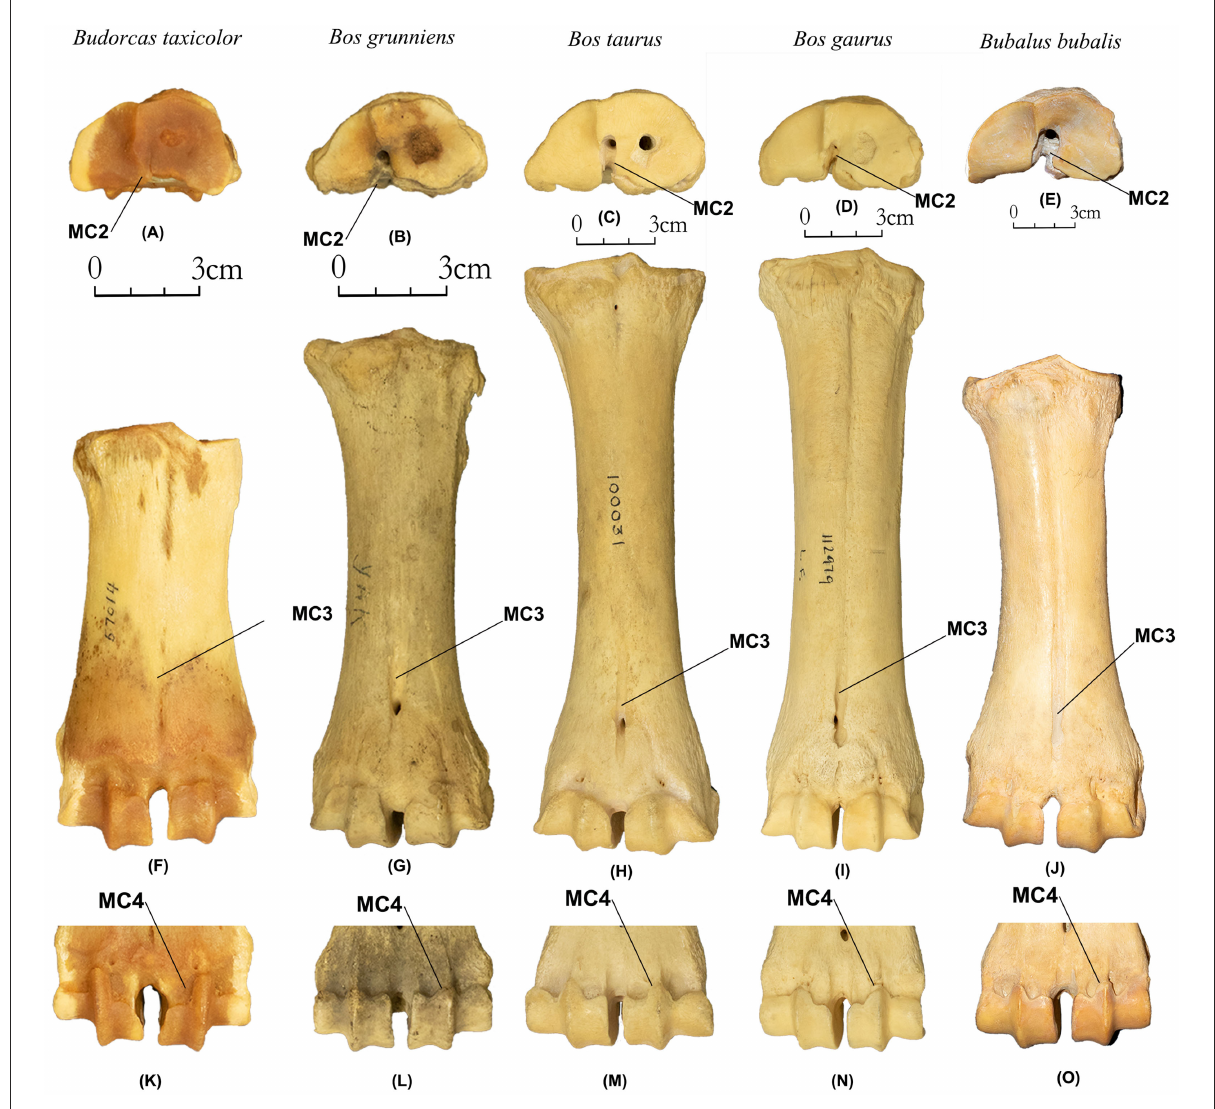
FIGURE6 Metacarpal of takins and Bovini. Proximal view: (A) Budorcas taxicolor (AMNH − 57014), (B) Bos grunniens (AMNH–M − 22909). (C) Bos taurus (AMNH–M − 77932). (D) Bos gaurus (AMNH–M − 112979). (E) Bubalus bubalis (AMNH–M − 54766). Anterior view: (F) Budorcas taxicolor (AMNH–), (G) Bos grunniens (AMNH–M − 22909). (H) Bos taurus (AMNH–M − 77932). (I) Bos gaurus (AMNH–M − 112979). (J) Bubalus bubalis (AMNH–M − 54766). Posterior view of distal end: (K) Budorcas taxicolor (AMNH − 57014), (L) Bos grunniens (AMNH–M − 22909). (M) Bos taurus (AMNH–M − 77932). (N) Bos gaurus (AMNH–M − 112979). (O) Bubalus bubalis (AMNH–M − 54766).